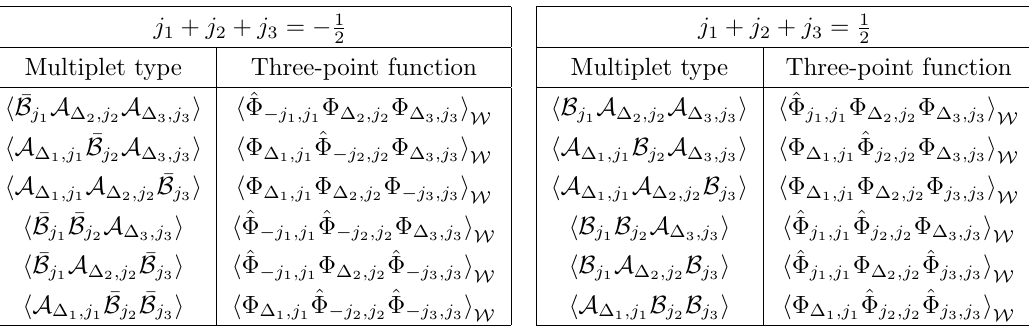
Table 2 . Non-vanishing three-point functions of super(cid:12)elds with j 1 + j 2 + j 3 = (cid:6) 1